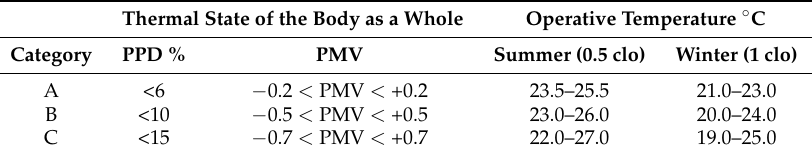
Table 7. Three categories of thermal comfort (ISO EN 7730, 2005).